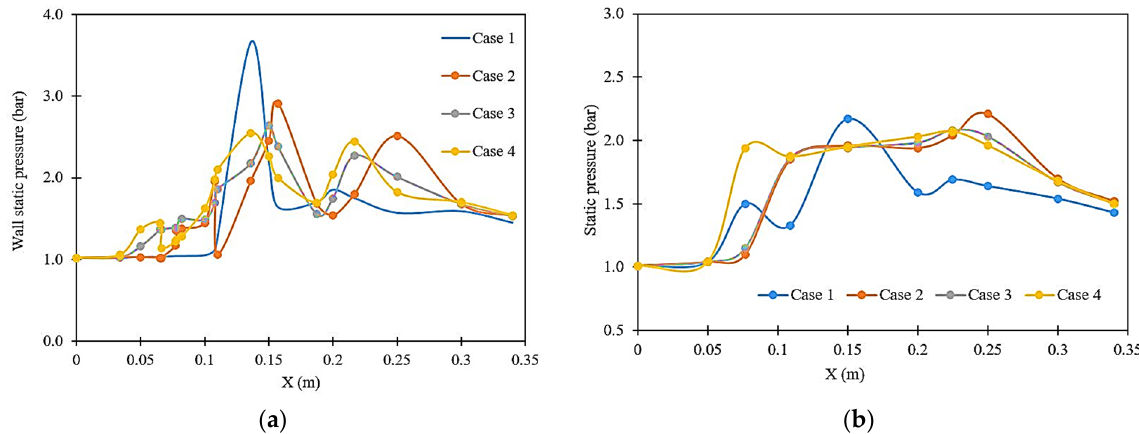
Figure 9. Static pressure distribution of various combustor geometries: ( a ) bottom wall pressure and ( b ) centerline pressure of the combustor.